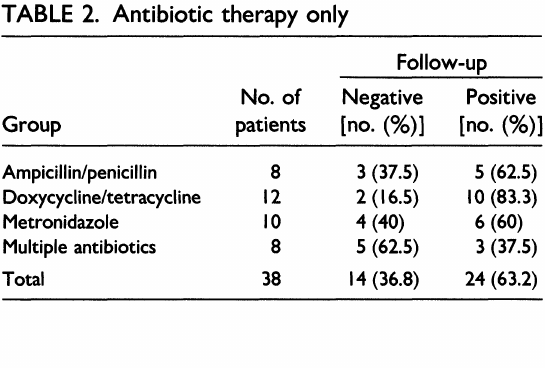
TABLE 2. Antibiotic therapy only Follow-up No. of Negative Positive Group patients [no. (%)] [no.